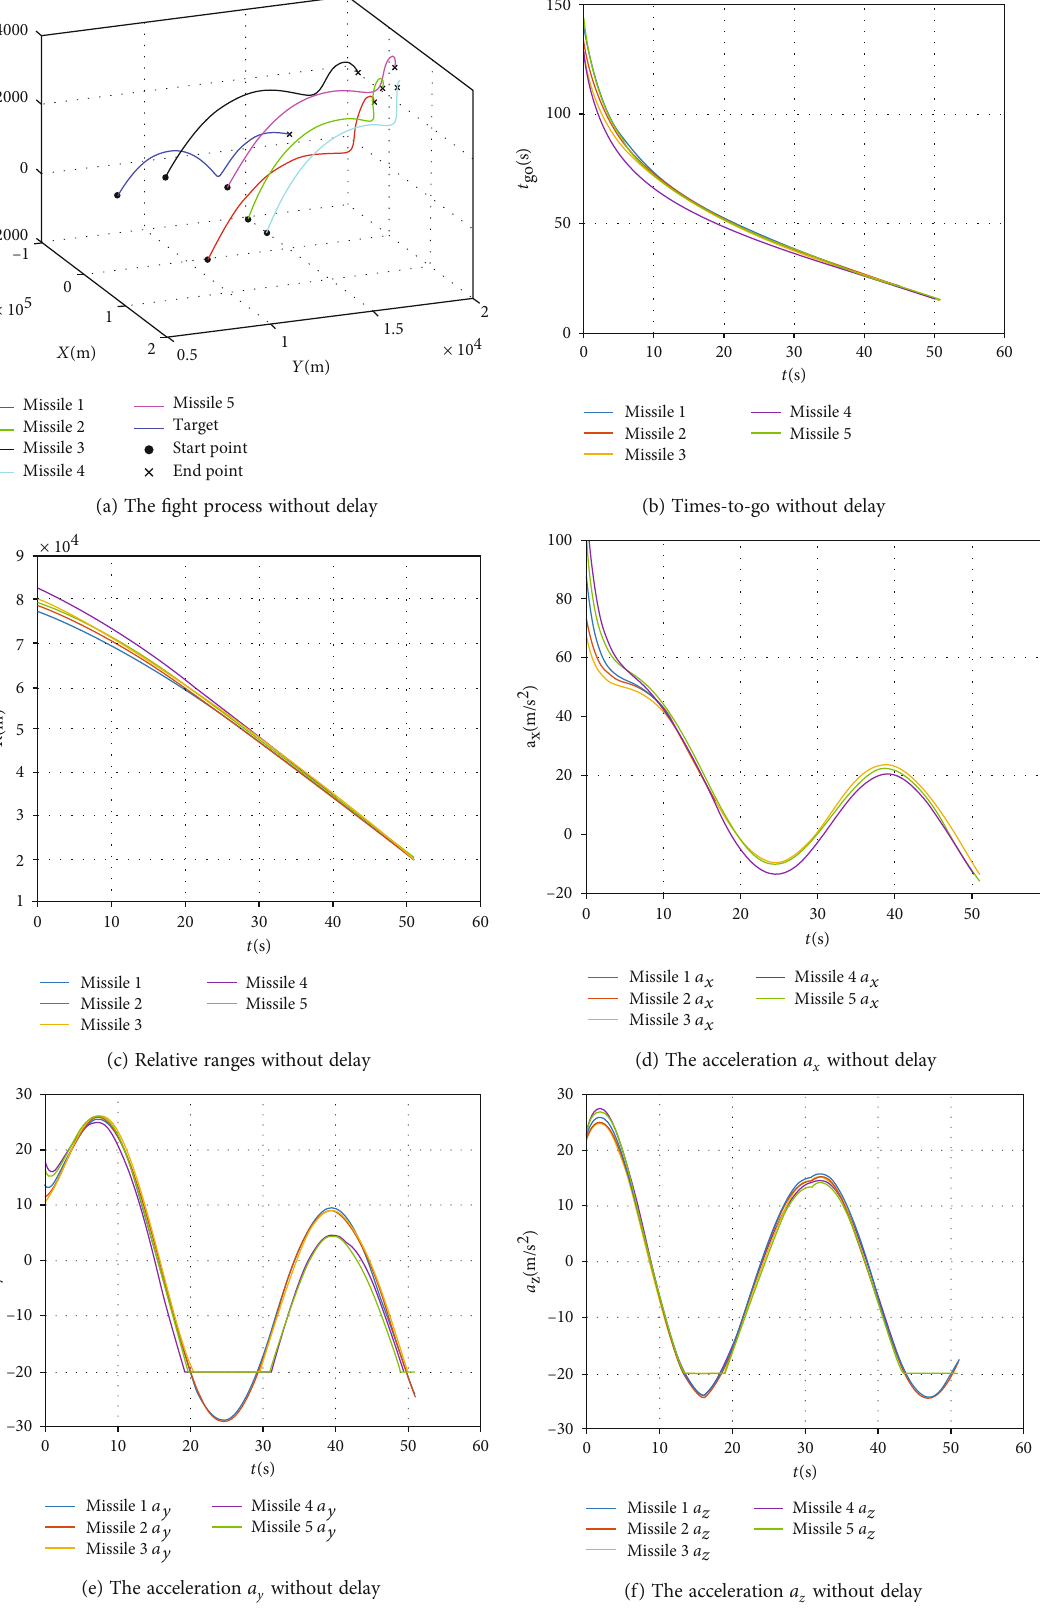
Figure 4: The simulation results without